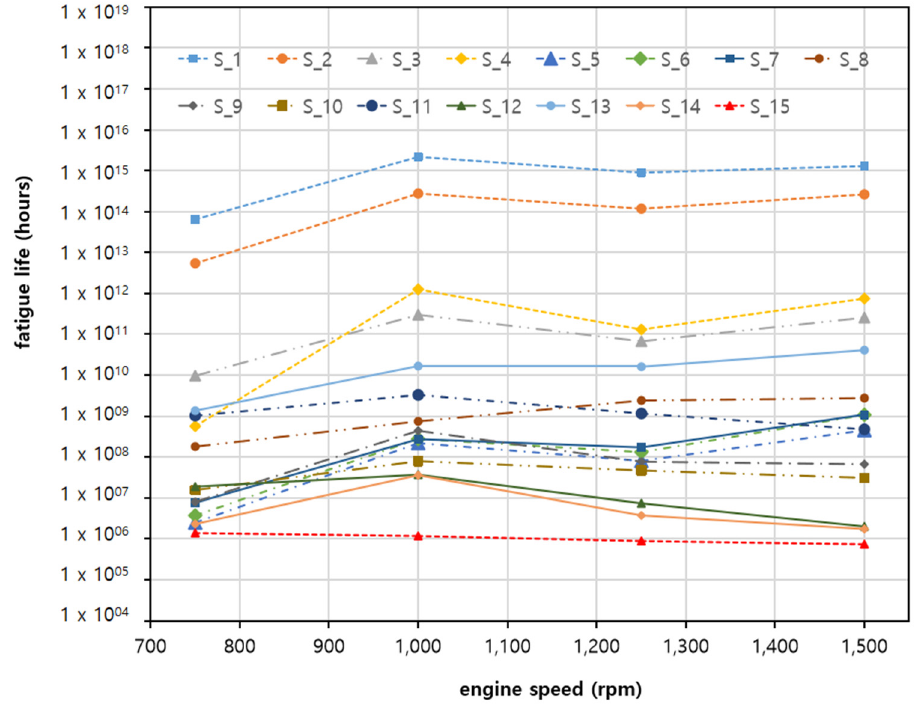
Figure 14. The average fatigue life of the transplanting device is according to the engine speed.